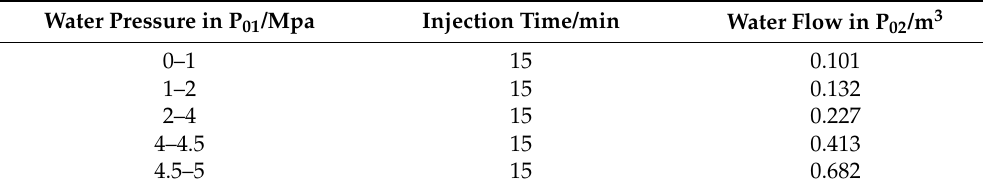
Table 2. Connectivity experiment between P 03 and P 02.